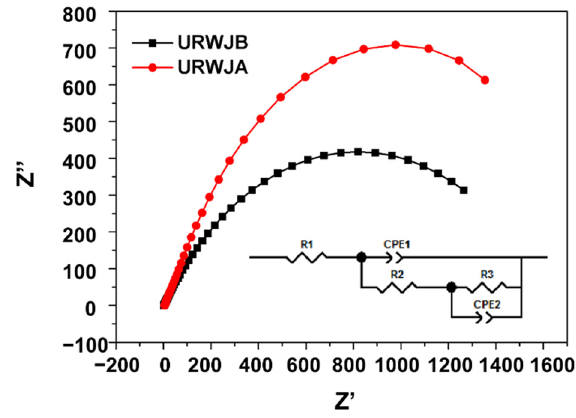
Figure 7. Nyquist plots of BM and URWJs.